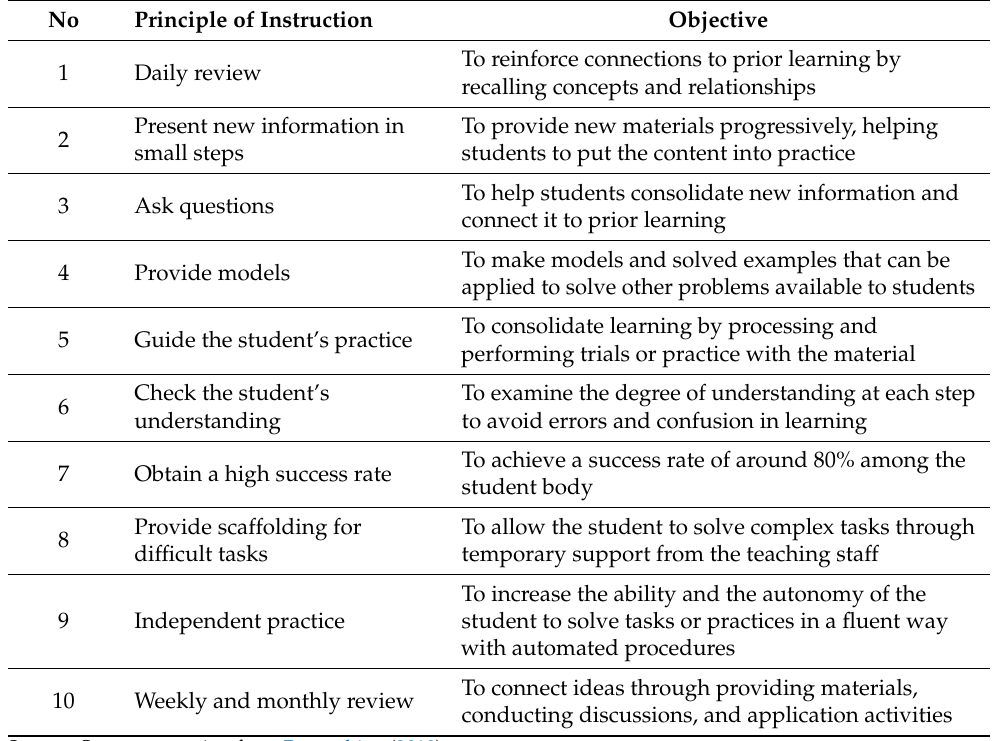
Table 1. Rosenshine’s Principles of